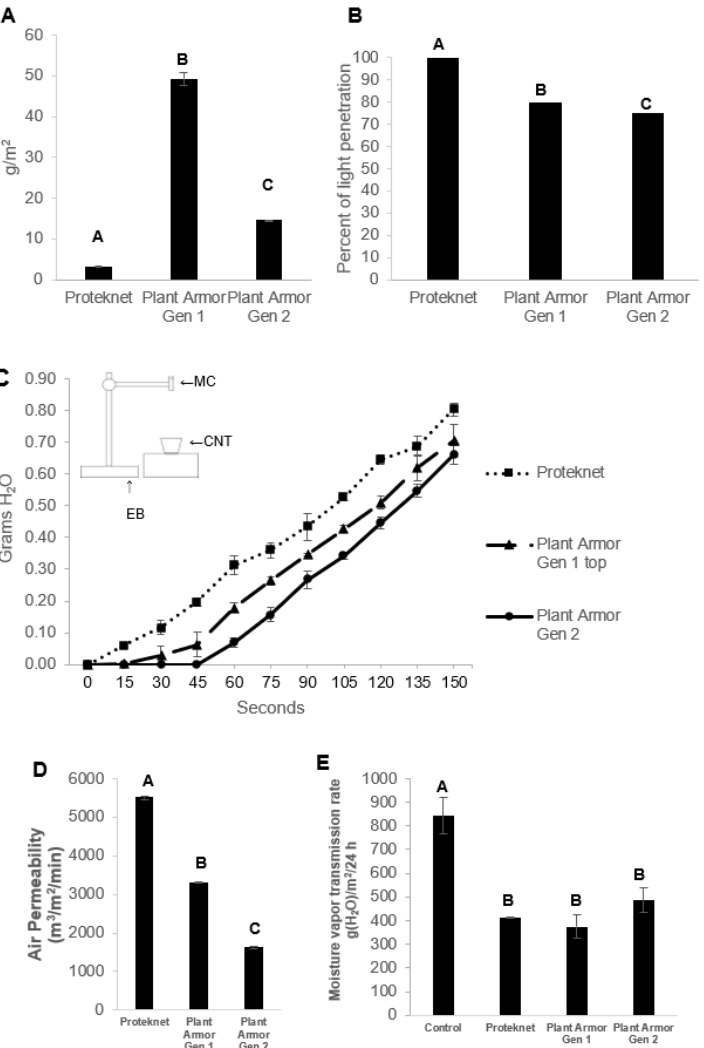
Figure 3. Physical properties of the textiles studied. ( A ) Average g/m 2 ; ( B ) percentage penetration of sunlight; ( C ) water penetration (insert showing device to measure water penetration (EB, electronic balance; CNT, container to hold water; MC, microcentrifuge tube); ( D ) air permeability; and ( E ) moisture vapor transmission across Proteknet and Plant Armor Generation (Gen) 1 and 2. Error bars are ± 1 SEM. In some cases, the error bars were too small to be visible. Treatments that were statistically significantly different as determined by ANOVA and Tukey’s test are indicated by different letters on the bar graph (exception was for ( C ) where there was no variation between replicates for each